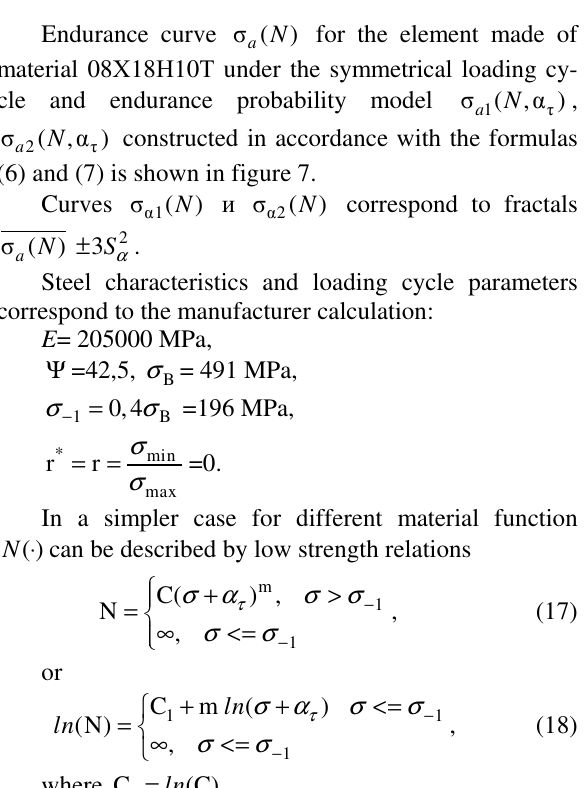
Fig. 6. The general scheme of component stressing and probability strength characteristics